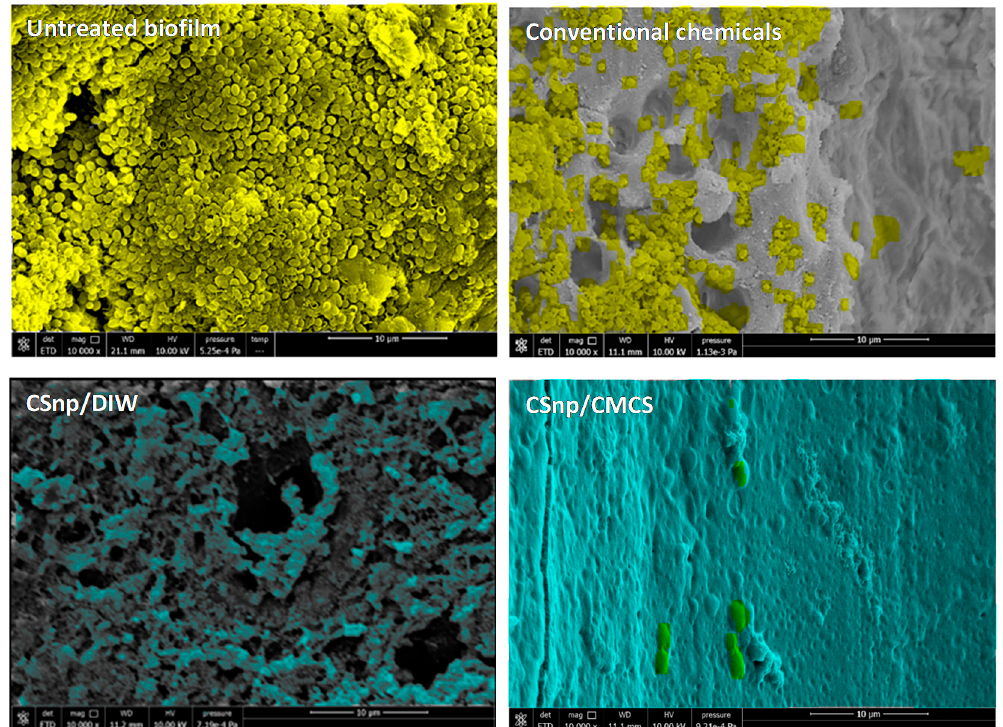
Figure 3. Scanning electron micrographs showing representative areas of root canal lumen of different groups of 6-week-old E. faecalis biofilm. Untreated biofilm displaying thick bacterial layer on the root canal wall and conventionally treated biofilm showing residual bacteria (pseudo-colored in yellow) versus CSnp treated biofilms which show CSnp-based layer covering the dentin surface (pseudo-colored in turquoise) (10,000× magnification).